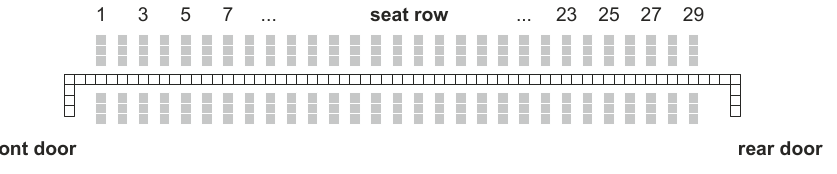
Figure 3. Grid-based simulation environment using an Airbus A320 seat layout as reference.